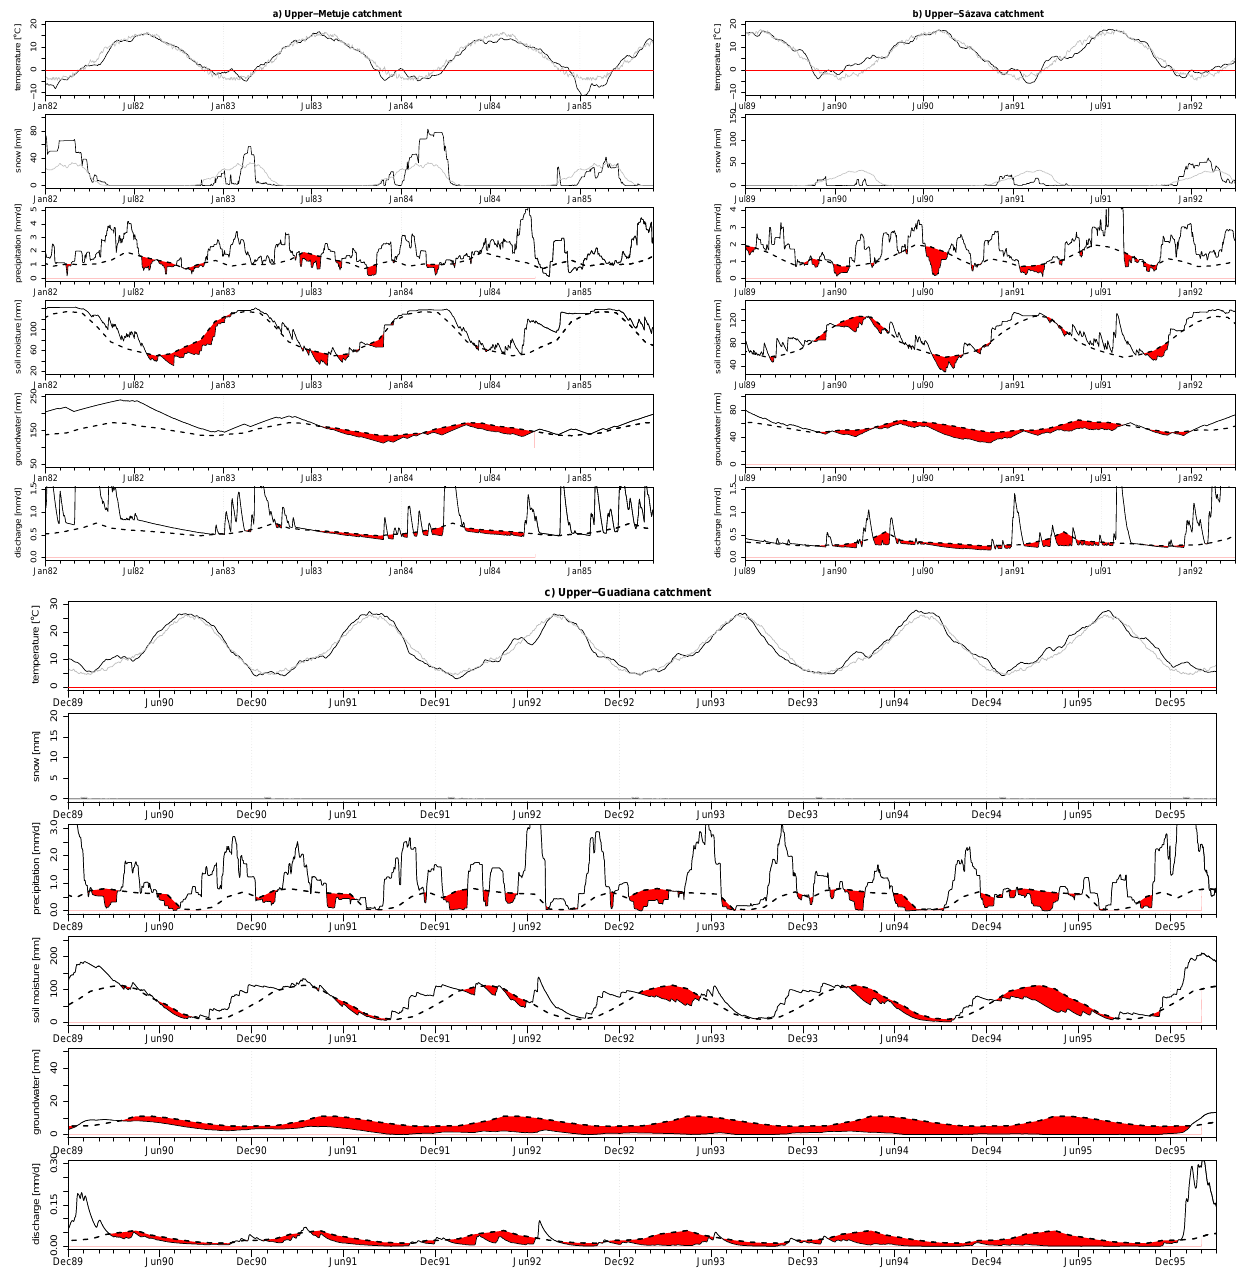
Fig. 10. Examples of composite drought type: (a) Upper-Metuje catchment 1982–1985, (b) Upper-S´azava catchment 1989–1992, (c) Upper- Guadiana catchment 1989–1995 (legend: see Fig. 5).